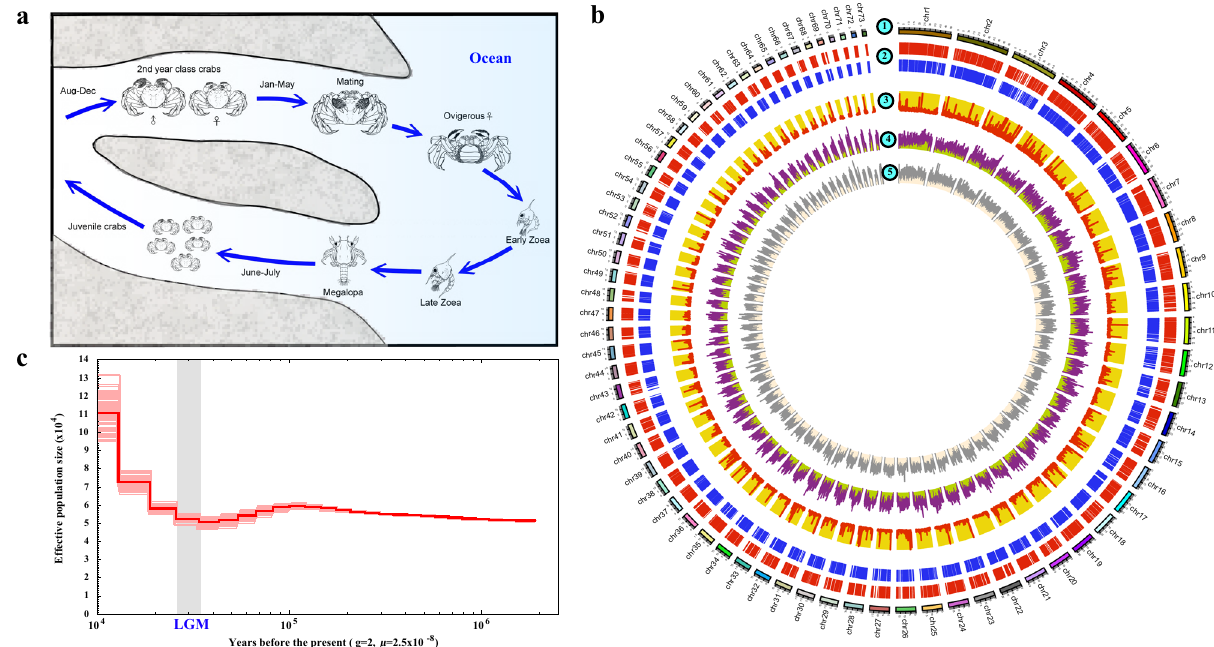
Fig. 1 Characterization of the Eriocheir sinensis genome. a The life cycle of E. sinensis . Adult crabs attain sexual maturity in estuaries followed by egg hatching and then upstream migration of megalopae to rivers and lakes. b The genome landscape of E. sinensis . From outer to inner circles: b1, marker distribution on 73 linkage groups at Mb scale; b2, protein-coding genes located on anchored scaffolds; b3, distribution of high- (>60%) and low-GC (<20%) contents in 200-bp regions across the genome within a 100-kb sliding window; b4, microsatellite distribution (1 – 6 bp) across the genome drawn in 100-kb sliding windows; b5, SNP density of resequenced individuals drawn in 100-kb sliding windows within a 50-kb step, with polymorphism hotspot regions ( P < 0.05) colored in red. The genomic visualization was created using the program Circos. c Demographic histories of mitten crab reconstructed using PSMC model. The period of the last glacial maximum (LGM, ~18,000 – 22,000 years ago) is shown as a gray bar. g (generation time) = 2 years; µ (neutral mutation rate per generation) = 2.5 × 10 − 8